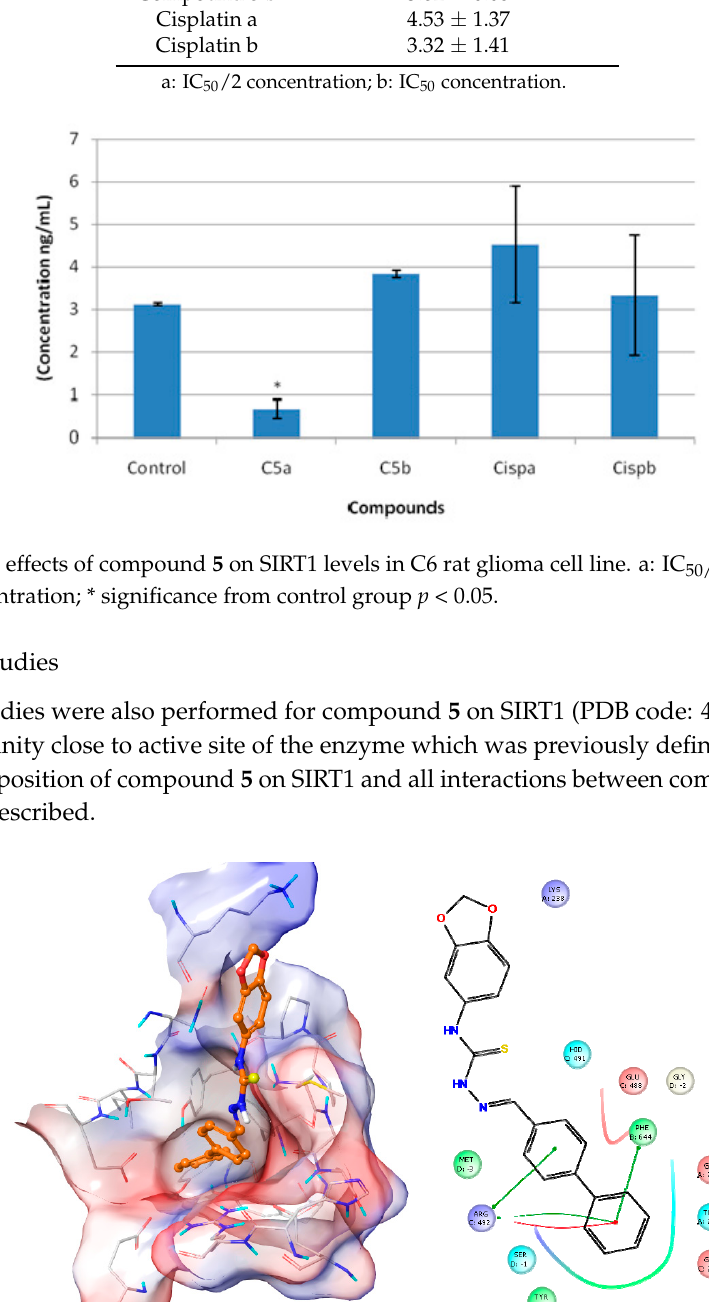
Table 5. The effects of compound 5 on SIRT1 Activity.